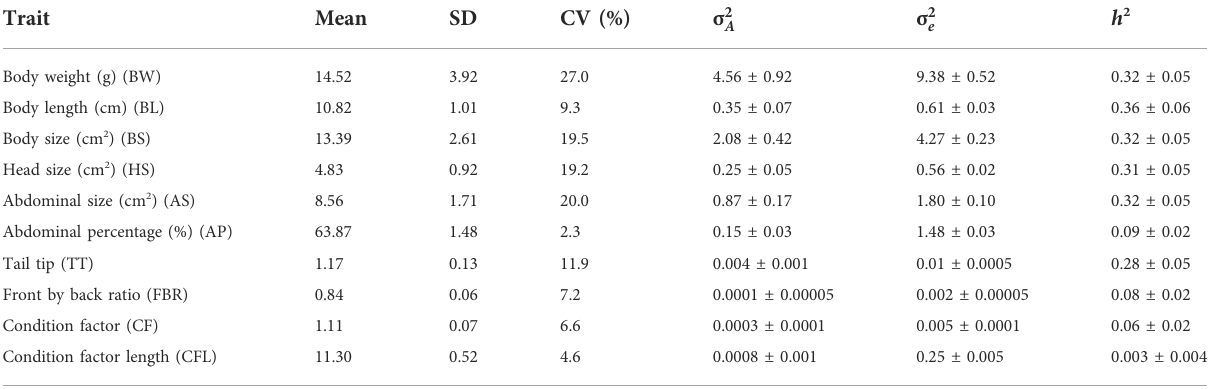
TABLE 3Mean, standard deviation(SD),coef fi cientofvariation(CV %),additivegeneticvariance( σ 2 A ),residualvariancecomponent( σ 2 e )andestimated heritability ( h 2 ) of morphological traits of shrimp ( n = 5,308).